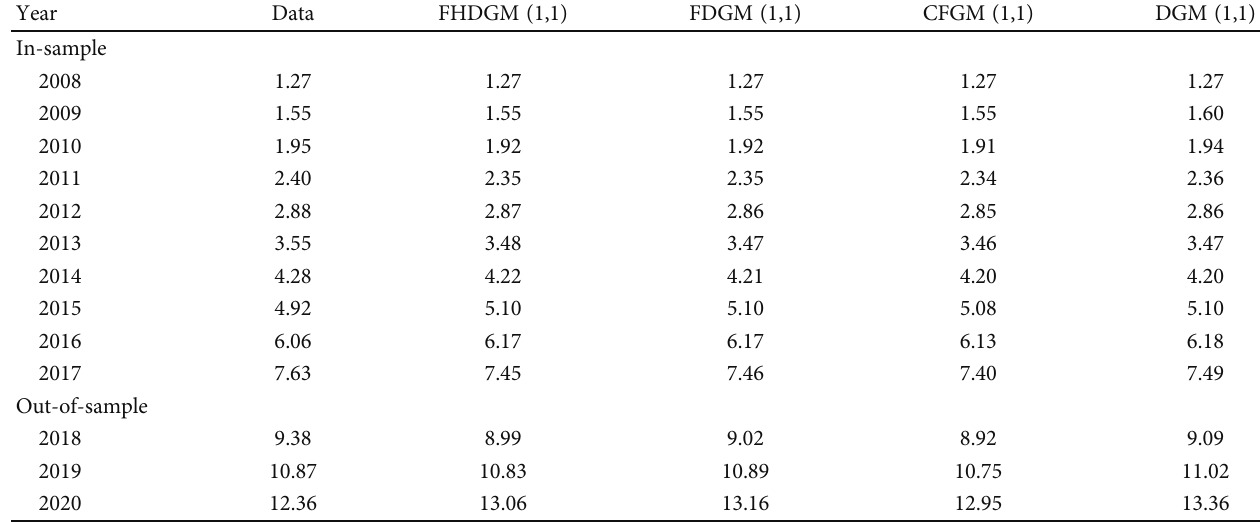
Table 7: Fitted and predicted values of the four models relating to renewable energy consumption in the Asia Paci fi c region.